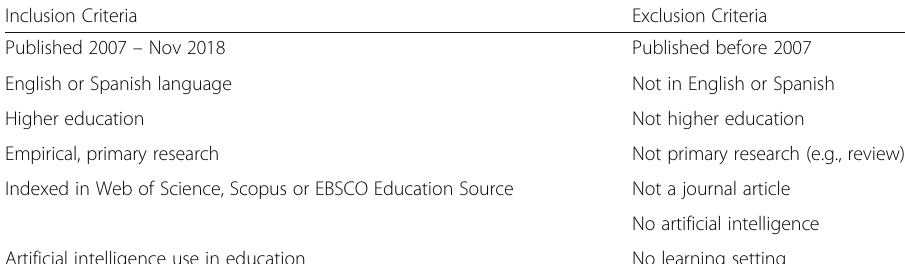
Table 2 Final inclusion and exclusion criteria Inclusion